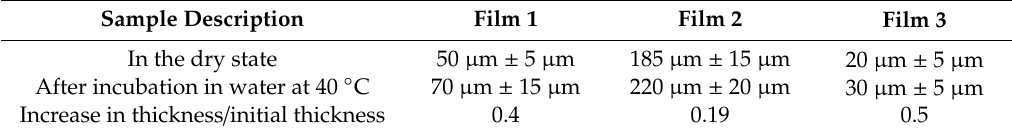
Table 2. Thickness of P(iPrOx-nPrOx) films in the dry state and after incubation in water at 40 ◦